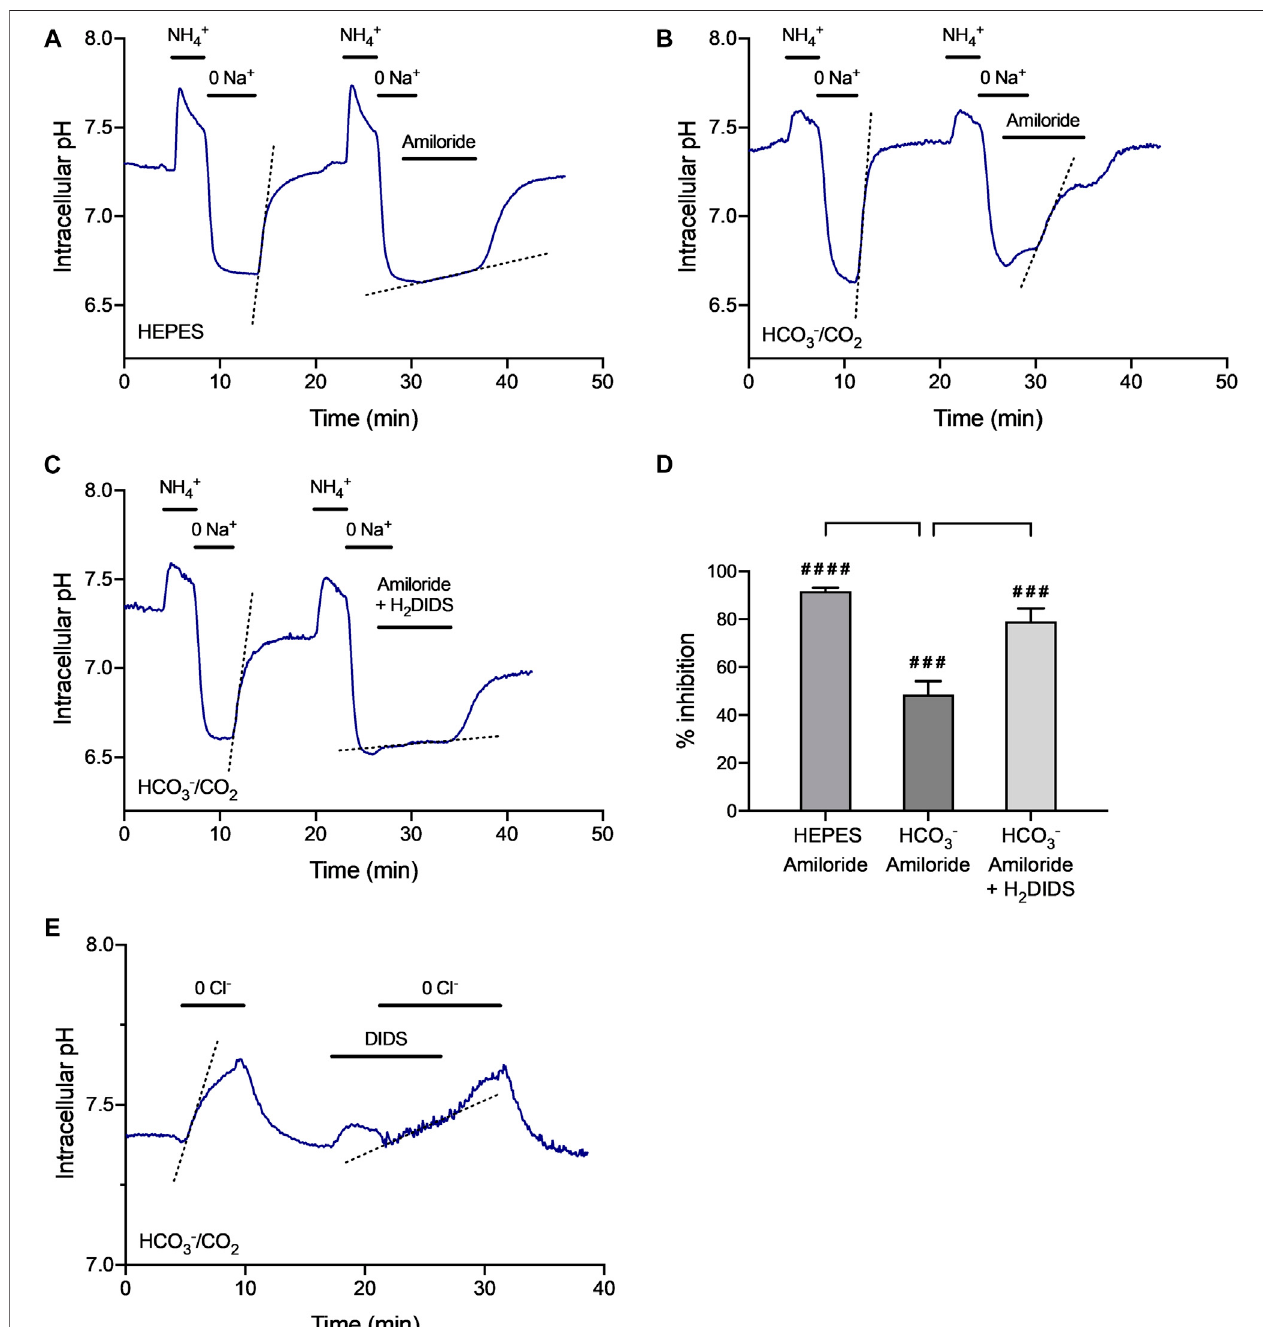
FIGURE 5 | | Regulation of intracellular pH in isolated HAT-7 spheroids. (A – C) Recovery of pH i from intracellular acidi fi cation evoked by a 3-min exposure to extracellular NH 4+ (20 mM) followed by substitution of extracellular Na + with NMDG + ( 0 Na + ): (A) in HEPES-buffered bath solution in the absence and presence of the Na + /H + exchange inhibitor amiloride (0.3 mM); (B) in HCO 3- -buffered bath solution in the absence and presence of amiloride (0.3 mM); (C) in HCO 3- -buffered bath solution in the absence and presence of amiloride (0.3 mM) together with the Na + -HCO 3 − cotransport inhibitor H 2 DIDS (0.5 mM). Dashed lines show the rate of recovery of pH i when Na + wasrestored to the perfusate. (D) Averaged data (mean ± SEM) from 4 – 6 experiments showing the inhibitory effects of amiloride and H 2 DIDS ontherateofrecoveryofpH i from acidi fi cation intheabsenceandpresence ofHCO 3 − .Percentage inhibitionwascalculatedwithreferencetotheinternalcontrolineach experiment. #### p < 0.0001, ### p < 0.001 compared with control (one-sample t test). ** p < 0.01, *** p < 0.001 (ANOVA and Tukey post-hoc test). (E) Changes in pH i evokedbysubstitution ofextracellularCl − withgluconate - ( 0Cl − )inHCO 3 − -bufferedbathsolutionintheabsenceandpresenceofDIDS(0.1 mM).Dashedlinesshowthe rate of recovery of pH i when Na + or Cl − was restored to the perfusate. Measurements of BCECF fl uorescence were pooled from 20 – 50 HAT-7 spheroids isolated from Matrigel matrix by treatment with 0.25% trypsin/EDTA. Traces are representative of 4 – 6 experiments.